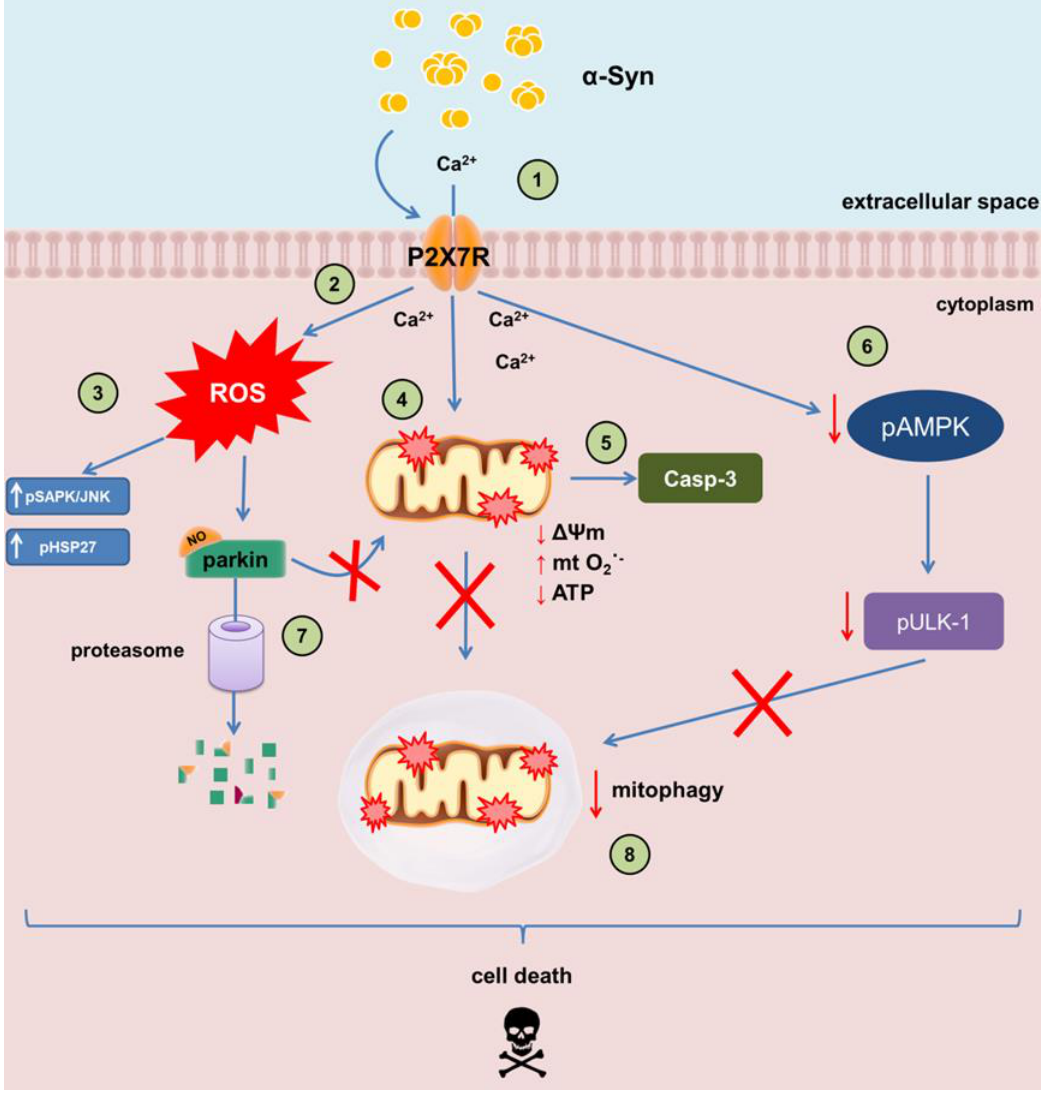
Figure 8. A schematic illustration of the molecular mechanisms involved in P2X7R‐mediated neurotoxicity of α -Syn. (1) Extracellular α -Syn is able to bind with and activate P2X7R. (2) Activation of P2X7R leads to the increased Ca 2+ influx and generation of ROS. (3) Elevation of free radicals synthesis leads to activation of stress response proteins SAPK/JNK and HSP27. (4) Stimulation of